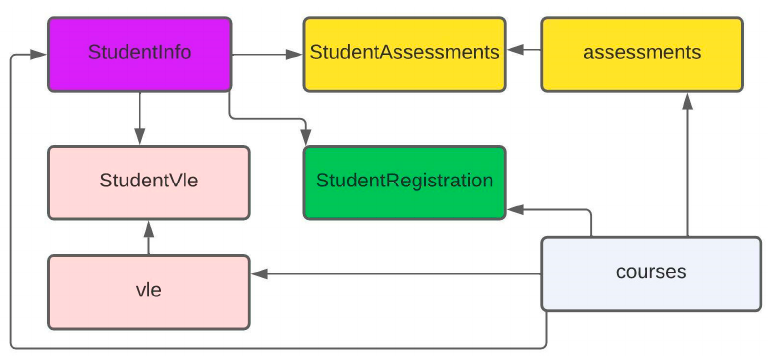
Figure 1. OU dataset structure. Table 1. New dataset transformed